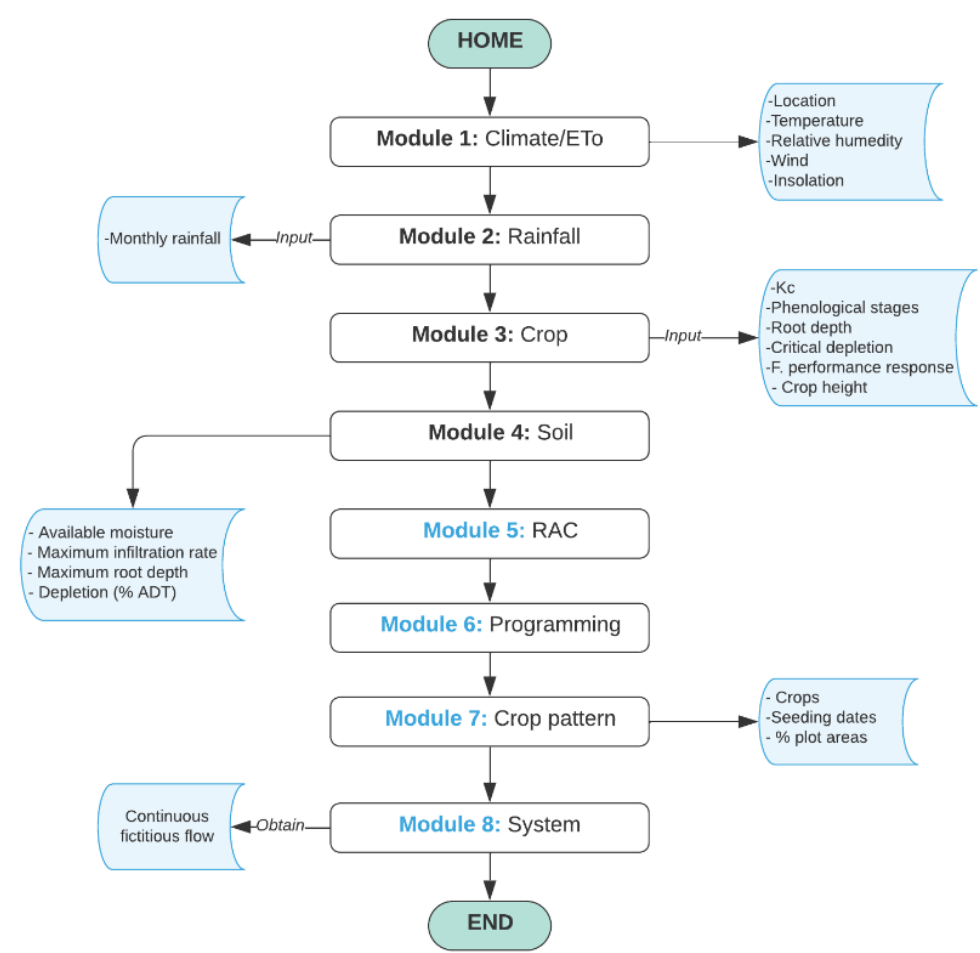
Figure 2. Flowchart of the CropWat 8.0 software modules.